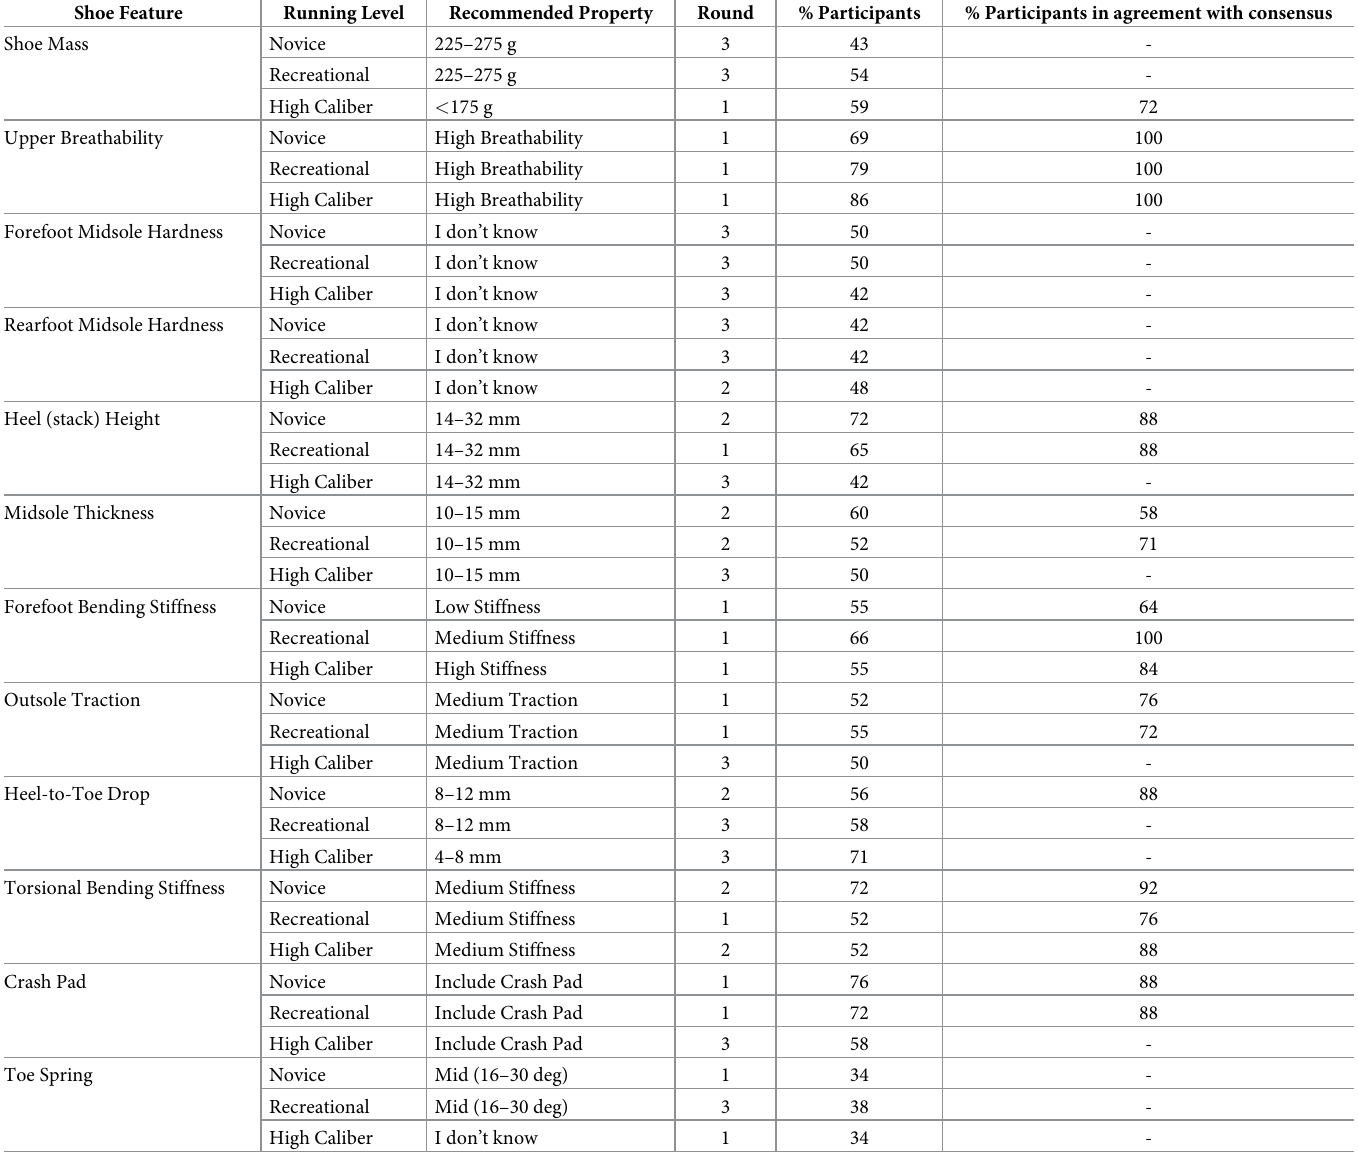
Table 5. Shoe feature properties that were most frequently chosen for each running